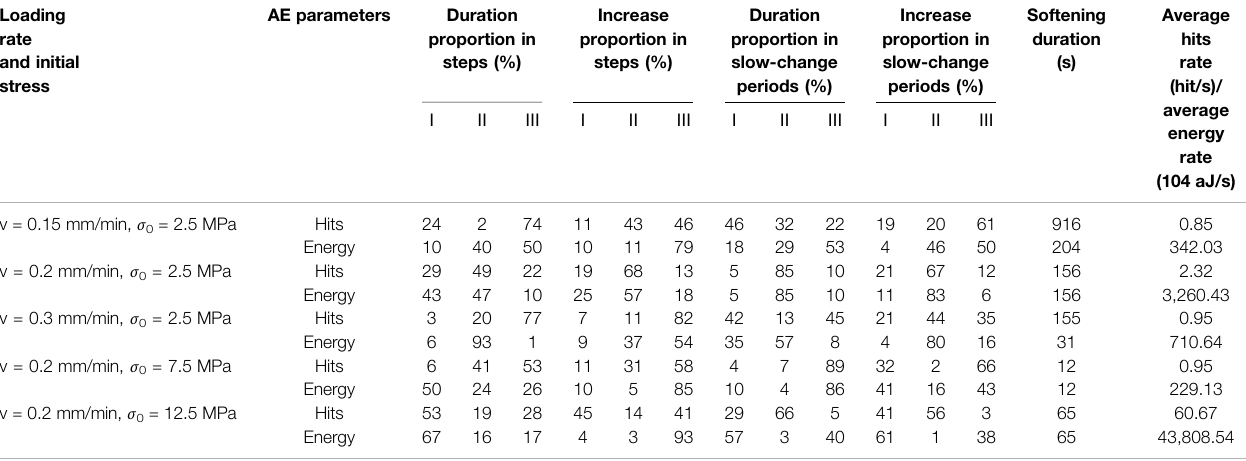
TABLE 4 | Duration proportion and increase proportion in each step and slow-change period. Loading rate and initial